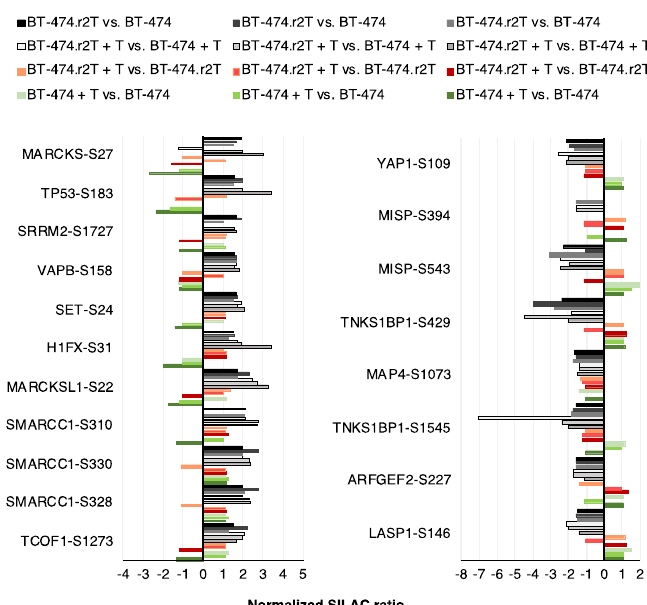
Figure 2. Phosphoproteomics analysis identified up- and downregulated candidates in acquired trastuzumab-resistant BT-474.r2T cells compared to parental sensitive BT-474 cells. Proteins selected in the phosphoproteomic SILAC assay according to their significantly downregulated or overexpressed phosphosites in BT-474.r2T vs. BT-474 cells (overlapping of the three datasets). Bar graphs represent FC of Class-1 phosphosites identified in different temporary conditions, with annotation of the modified residue.